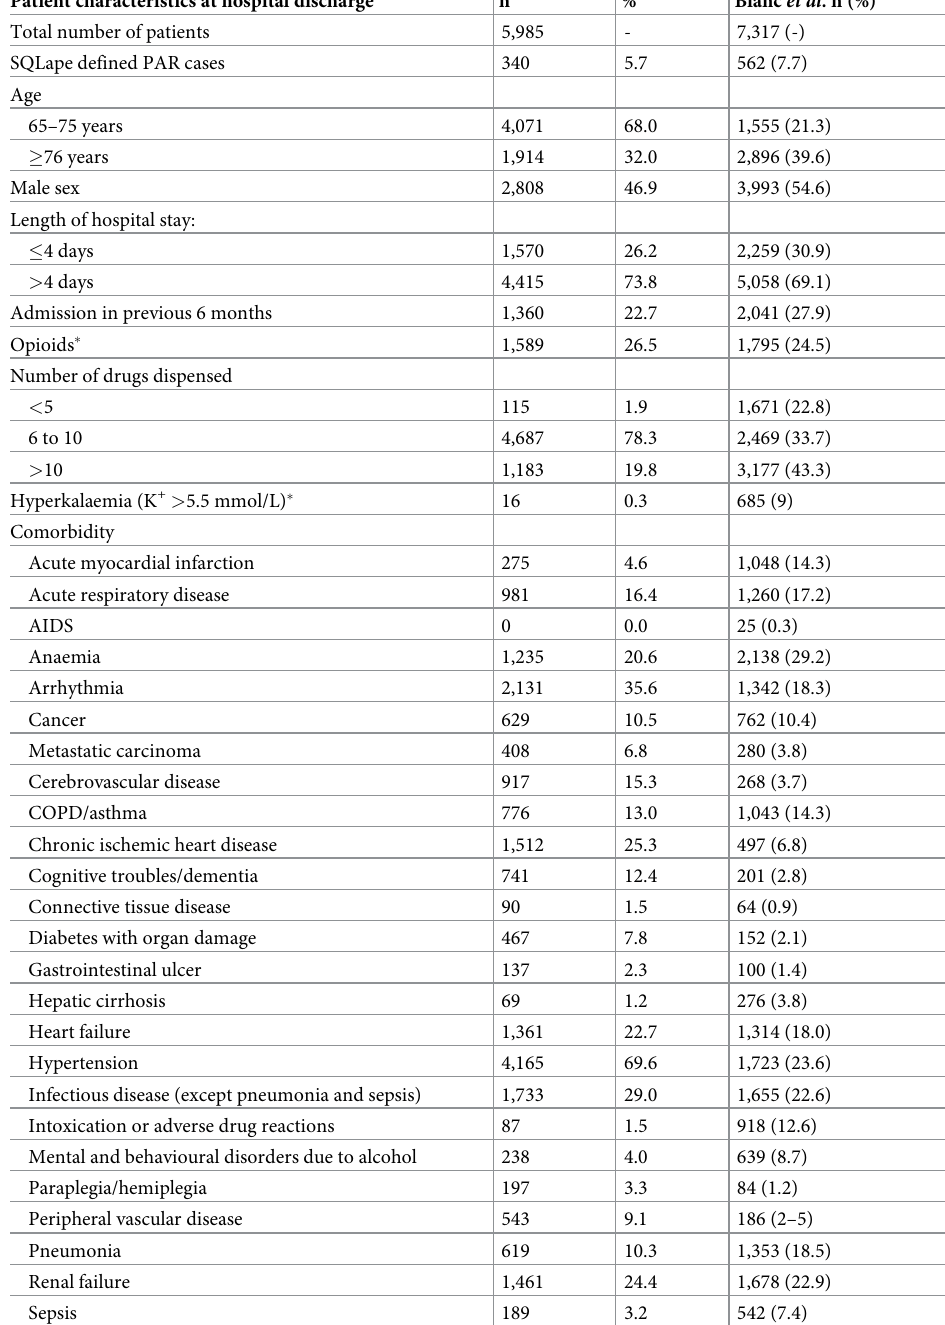
Table 1. Patient characteristics of the